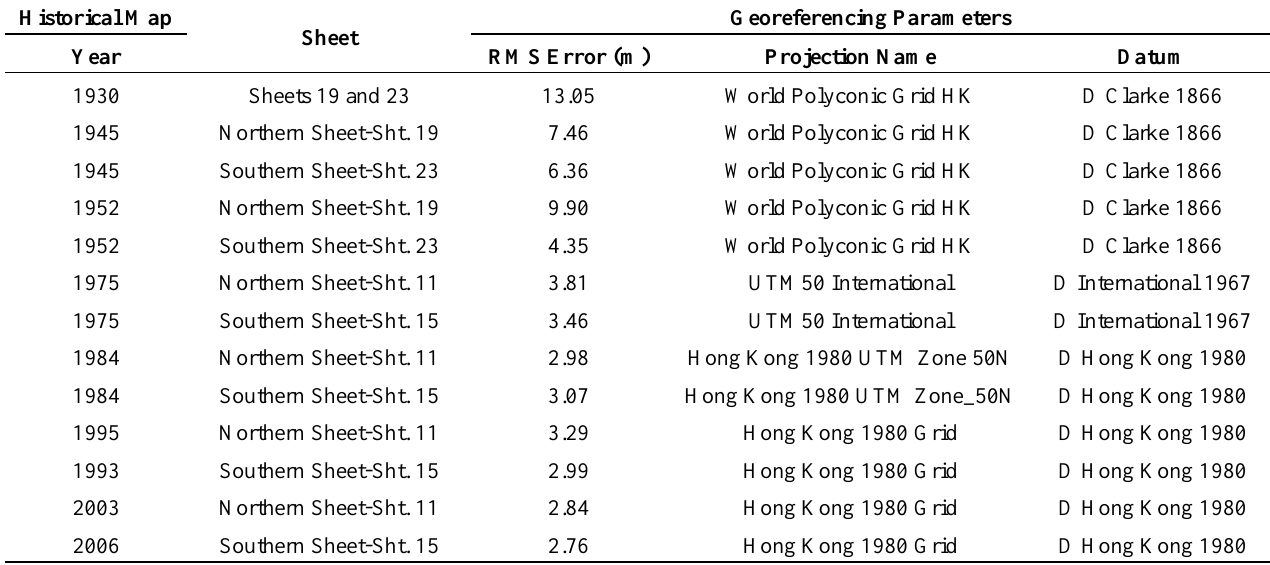
Table 1. Historical maps (1:20,000) used in this